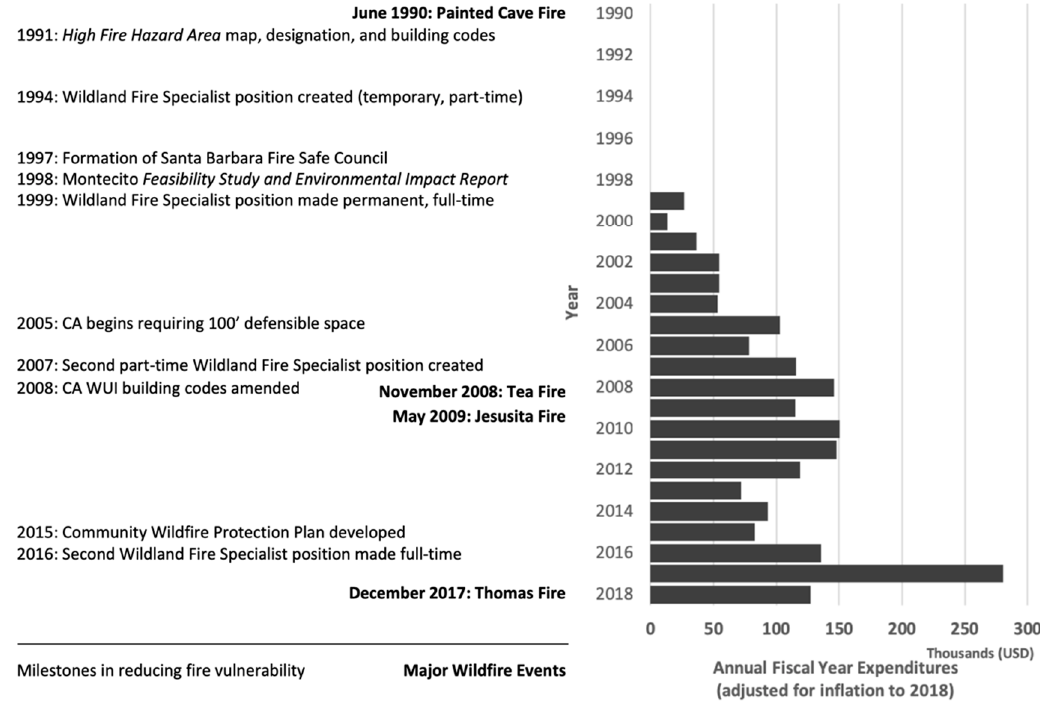
Figure 2. Timeline of Montecito Fire Protection District milestones, major fires, and annual budget (not including salary or benefits for Wildland Fire Specialists) dedicated to the Wildland Fire program.